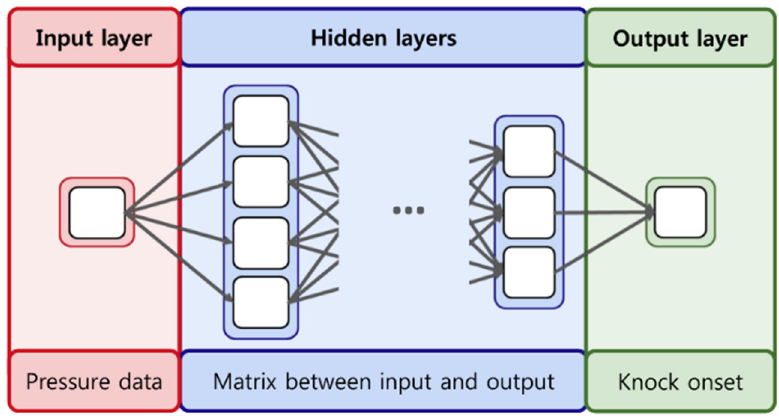
Figure 4. Structure of deep learning and its input and output